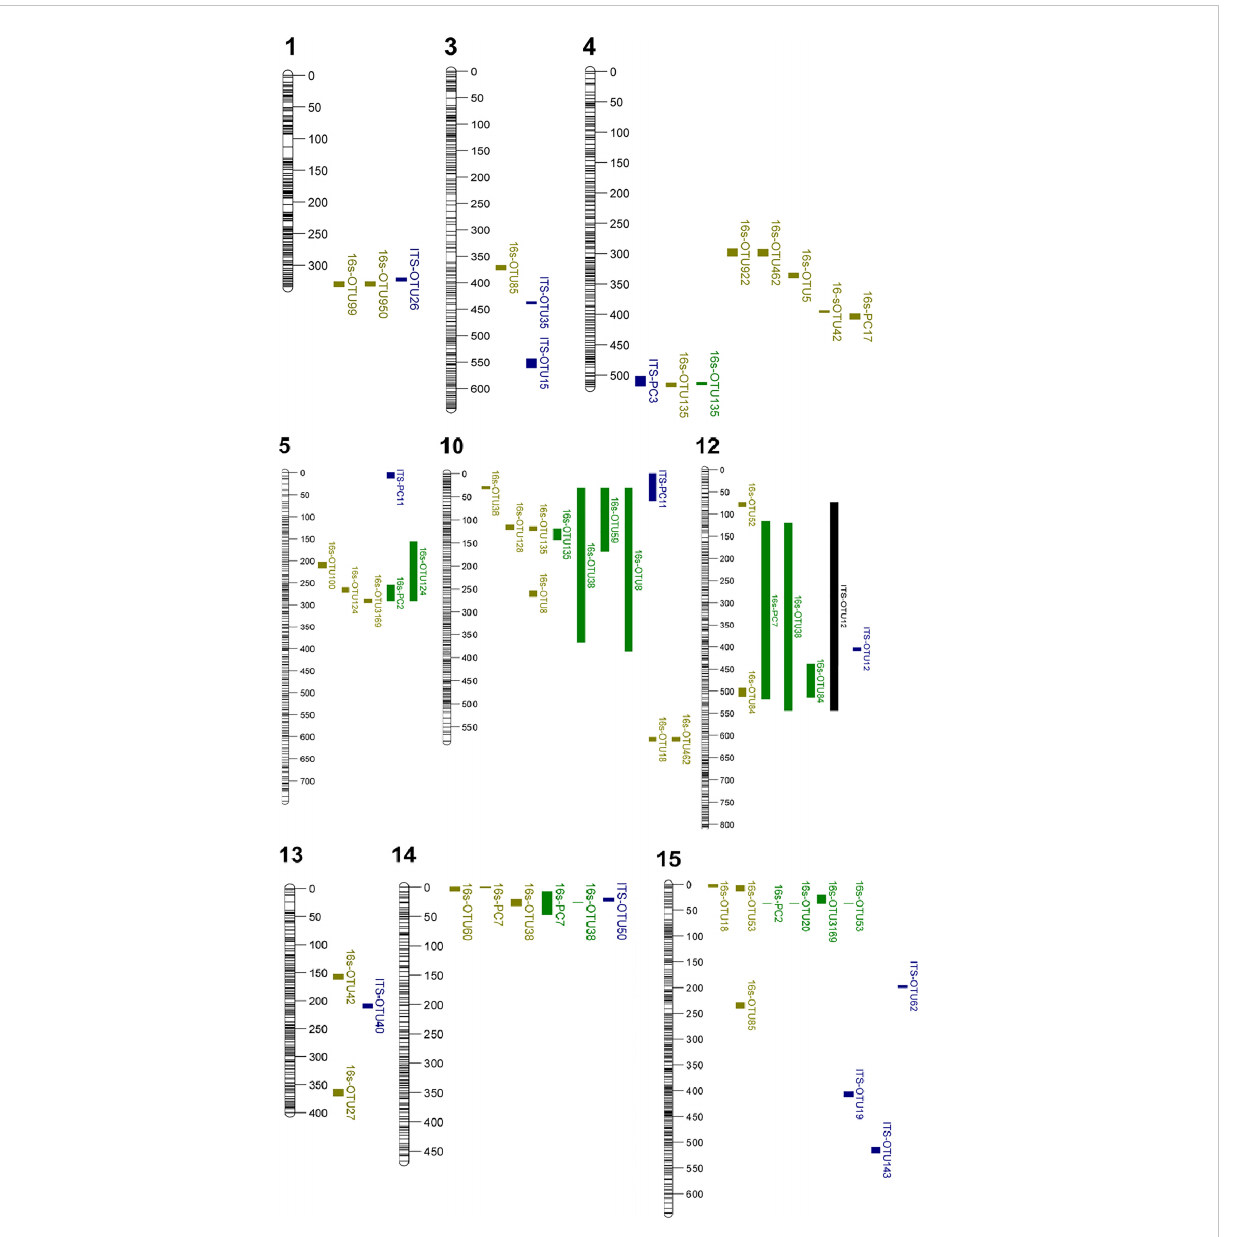
FIGURE 1 Linkage groups with QTL positions from the composite interval mapping (CIM) and Kruskal-Wallis (K-W) test. Phenotype colour indicates which analysis the QTL is associated with, yellow: 16s CIM analysis, blue: ITS CIM analysis, green: 16s K-W test, black: ITS K-W test. The fi gure only shows linkage groups with QTL interval supported by more than one